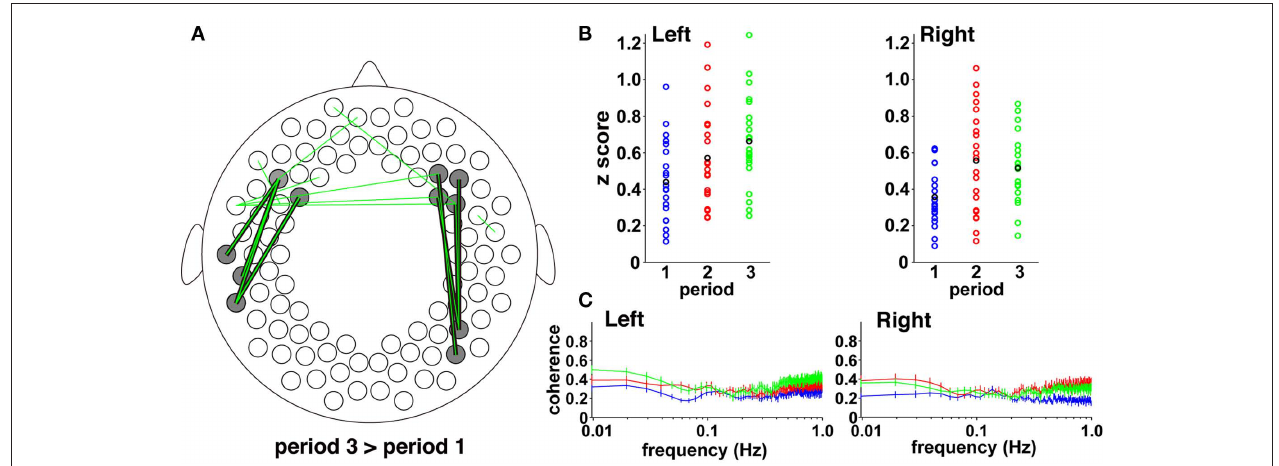
respectively. The black circles indicate mean values in each period. (C) The magnitudes of squared coherence between the frontal and temporal channels. We calculated the squared coherence of oxy-Hb signals between the four pairs in each hemisphere, shown in (A) . The four values for each frequency were averaged for each infant. The blue, red, and green lines indicate the mean values in periods 1, 2, and 3, respectively (error bar: the SE). Data below 1 Hz were presented in each period. The abscissa and ordinate show the frequency in a log scale and the magnitude of squared coherence,